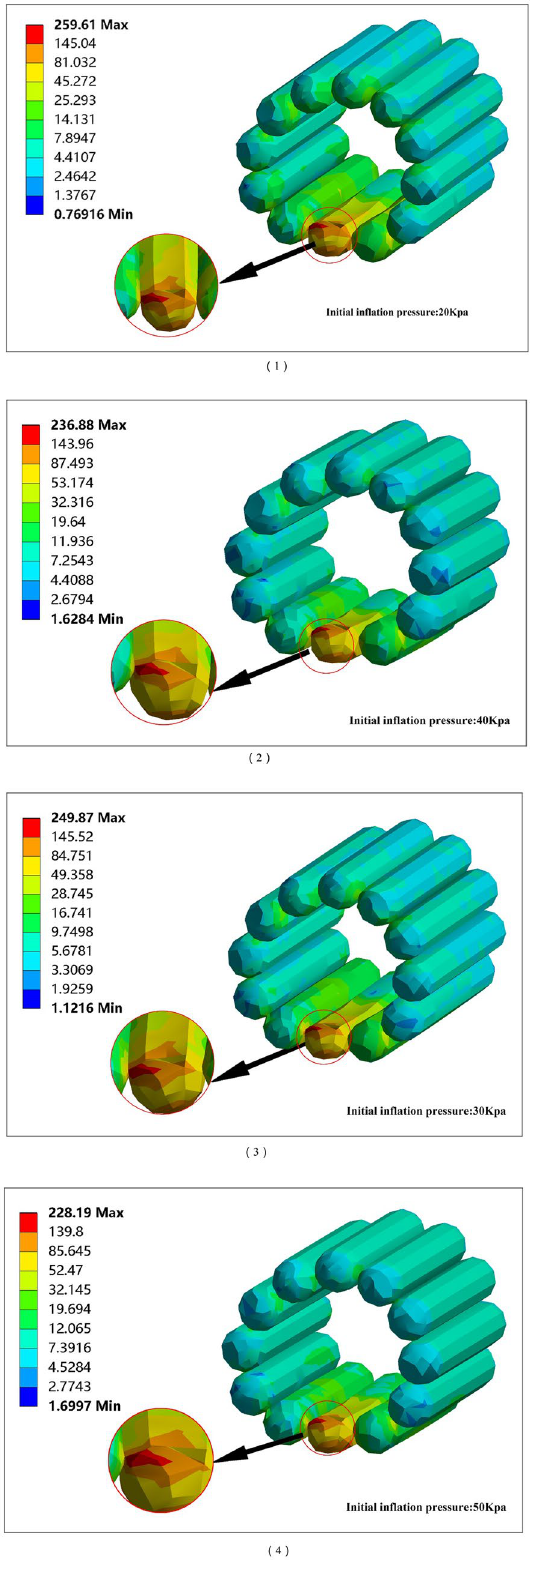
Fig. 8 Maximum stress distribution diagram of air column bags with different inflation pressures